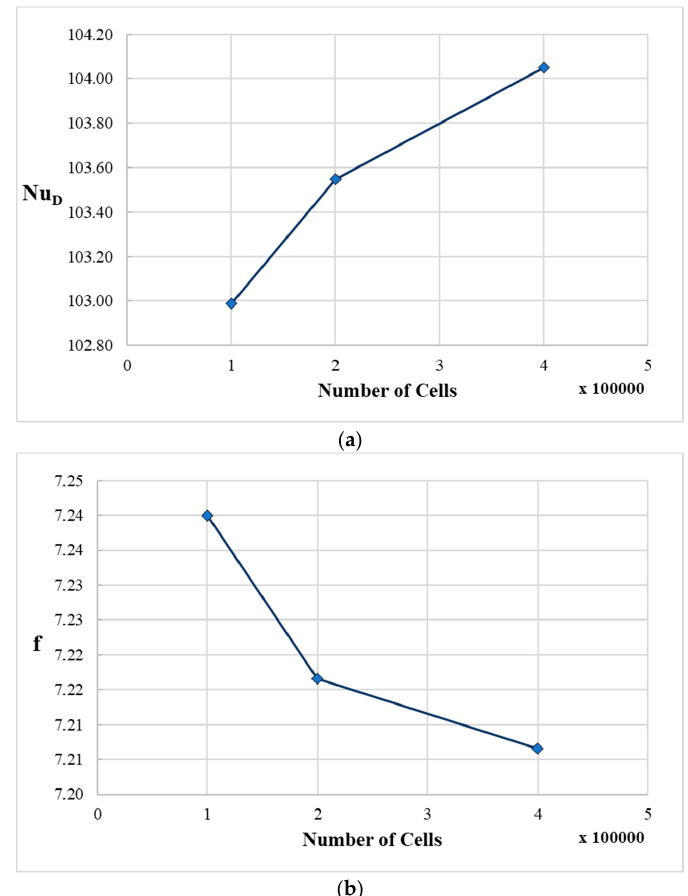
Figure 3. Grid independence test ( a ) for Nusselt number and ( b ) for friction factor.